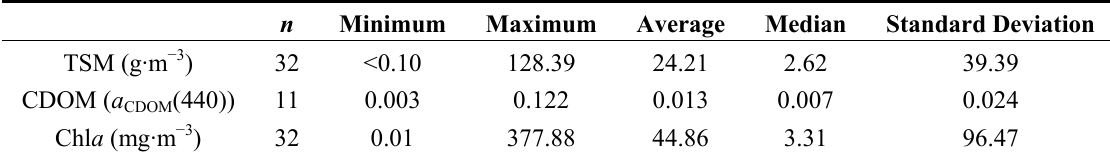
Table 2. Descriptive statistics of total suspended matter (TSM), CDOM and chl a measurements used in UFL laboratory tank calibration.